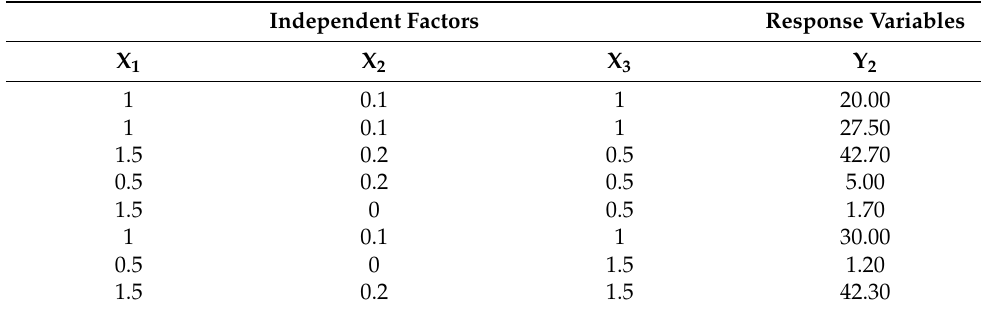
Table 2. Experiments to start the (Gauss Process-GP)